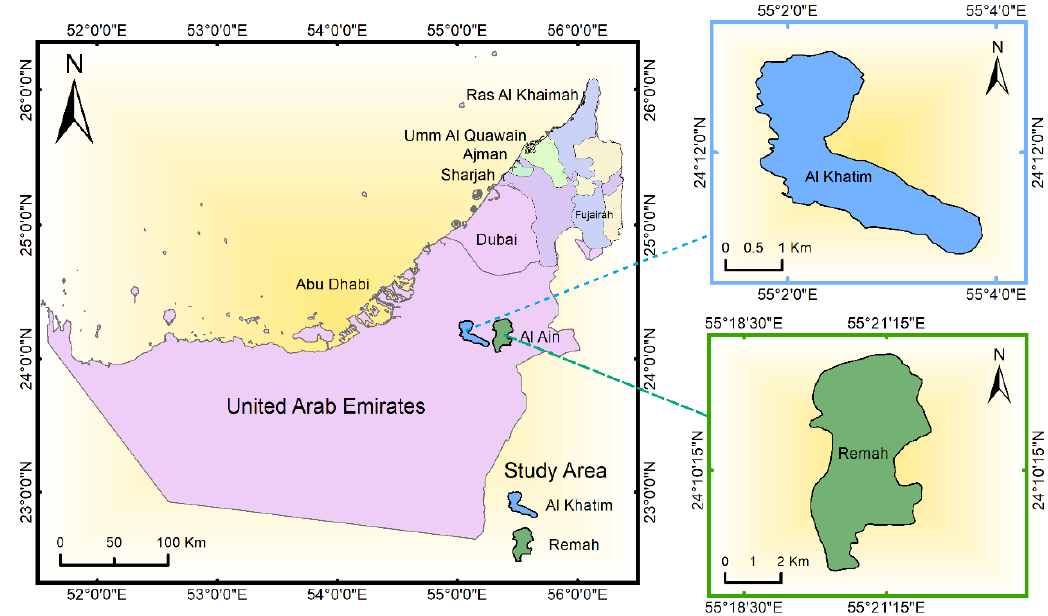
Figure 1. Al Khatim and Remah study areas located in the eastern region of United Arab Emirates.